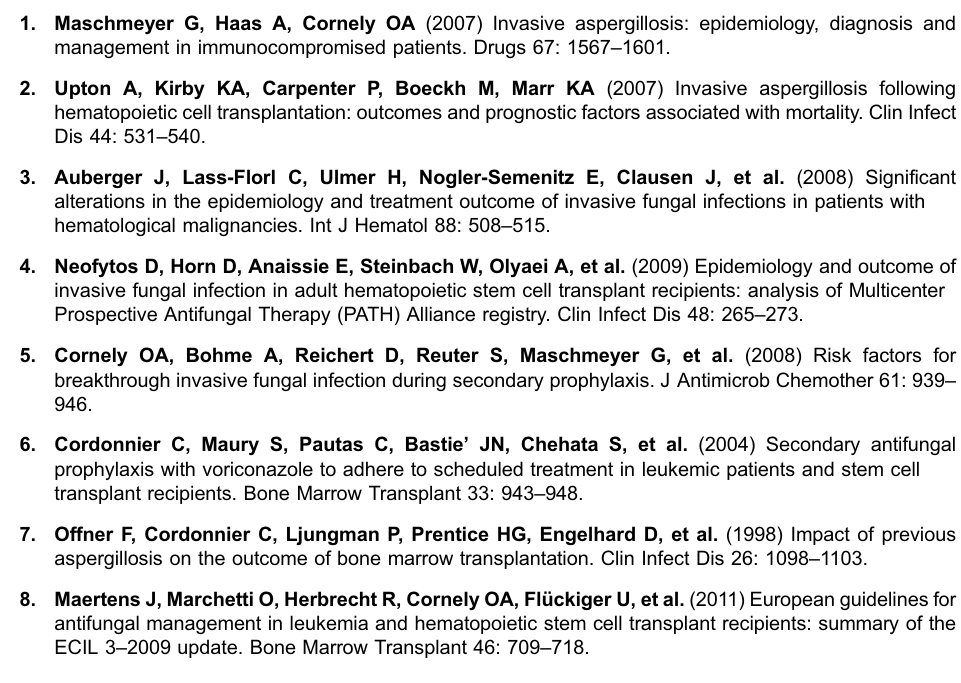
S1 Table. Clinical characteristics of 164 patients with previous IFD. S2 Table. Diagnostic criteria and results for the 40 patients with recurrent